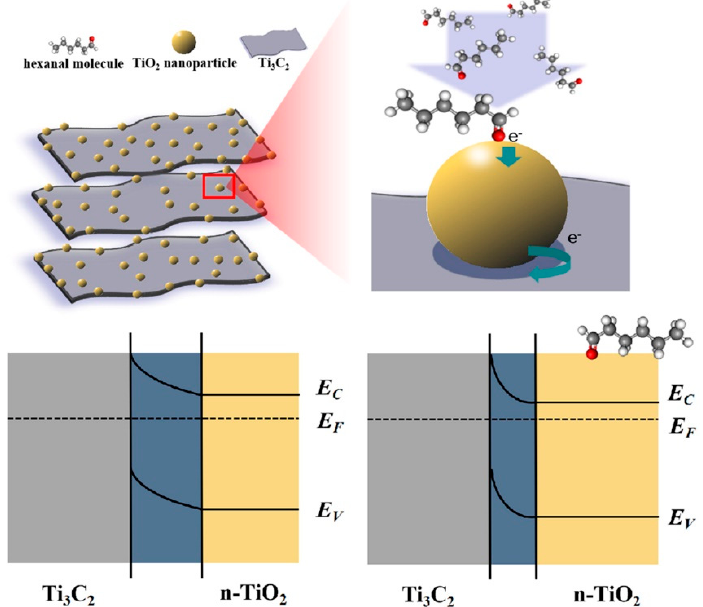
Figure 13. Schematic illustration of the sensing mechanism of the TiO 2 -Ti 3 C 2 nanocomposite for hex- anal and the proposed energy band structure diagram. Reprinted with permission from [110]. Cop- yright 2021: Elsevier B.V.